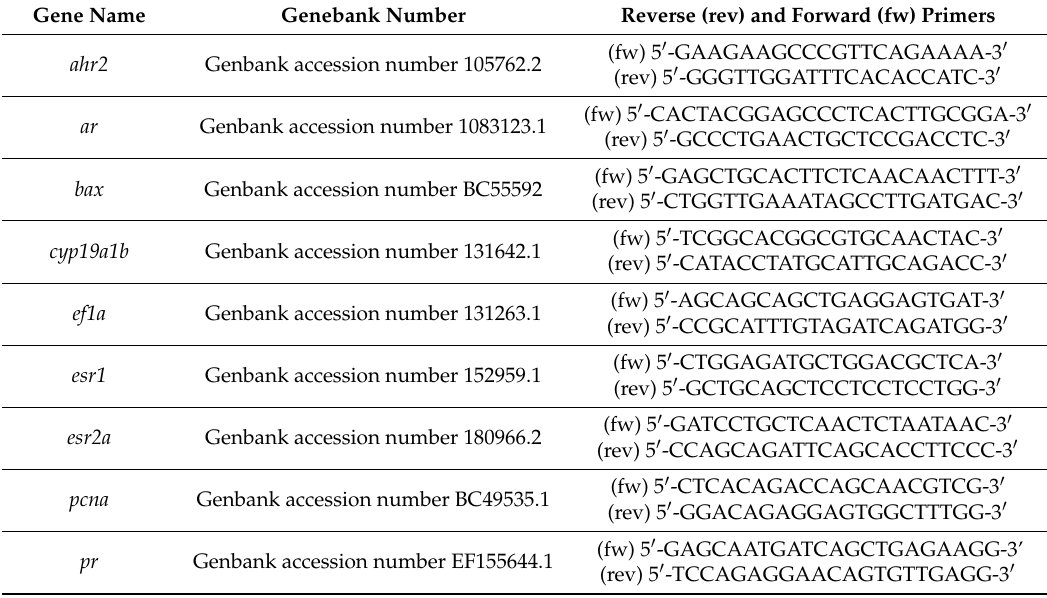
Table 1. Primers used for qRT-PCR